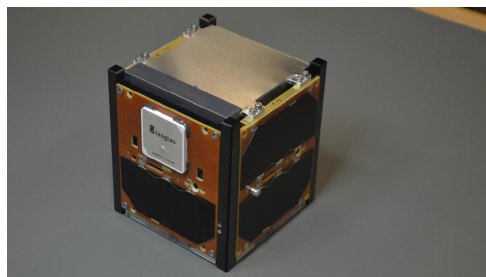
Figure 1. GRBAlpha, a 1U CubeSAT equipped with a gamma-ray detector (visible on the top, see [25] for details).